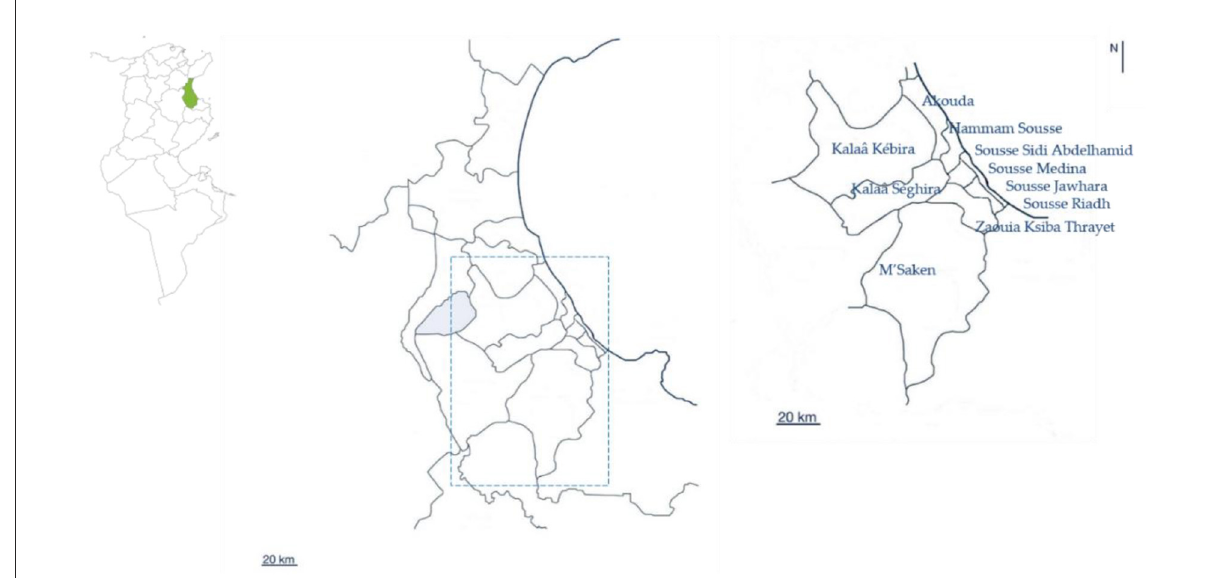
FIGURE1 Location of the urban agglomeration of Sousse. Own source.